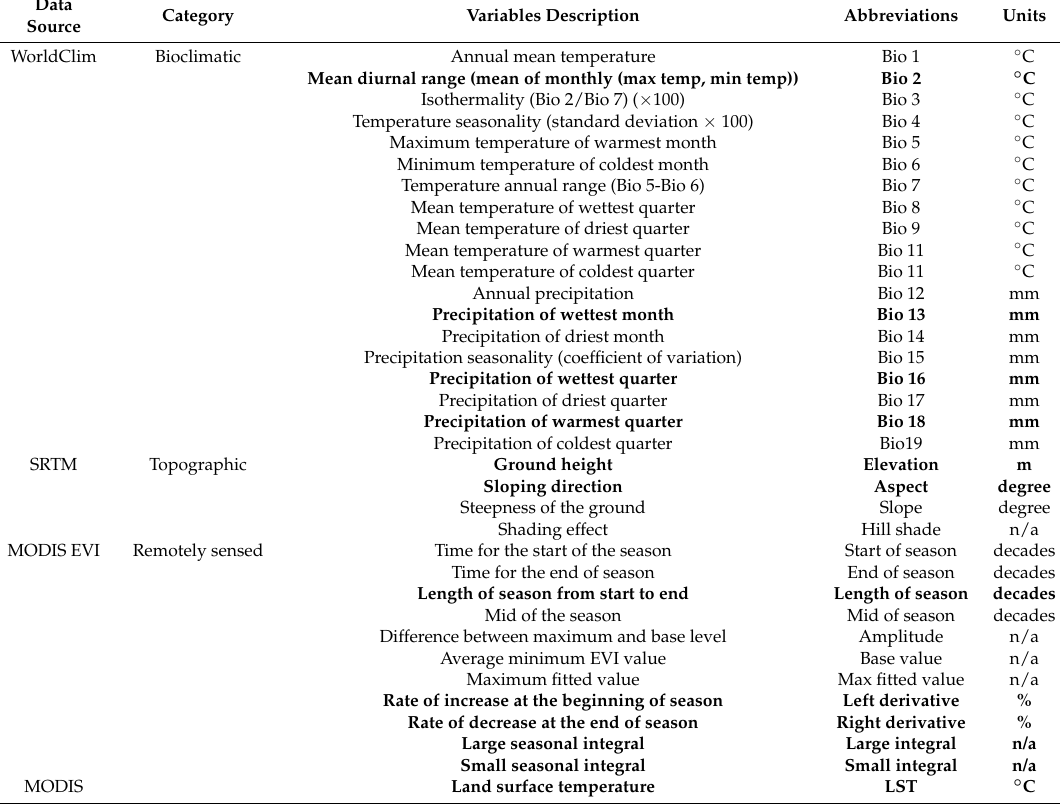
Table 1. Predictor variables used for modeling the ecological niche for the African citrus triozid ( Trioza erytreae ). The variables were divided into two sets; environmental (bio-climatic and topographical) and remote-sensing variables. Bold text refers to variables which were selected through a multi-collinearity test using the Findcorrelation function in the caret package in the R software and finally used in the MaxEnt